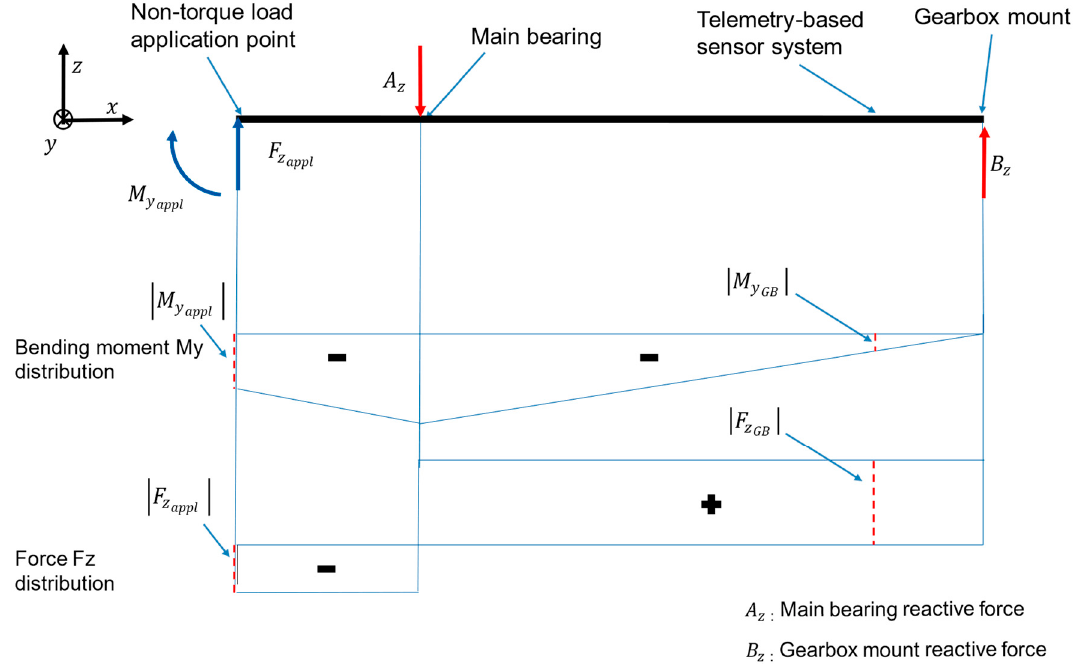
Figure 4. Bending moment around the y -axis ( M y ) and force along the z -axis ( F z ) distributions along the LSS of an example load case with applied bending moment M y 𝐹 (cid:3053) . (cid:3276)(cid:3291)(cid:3291)(cid:3287)